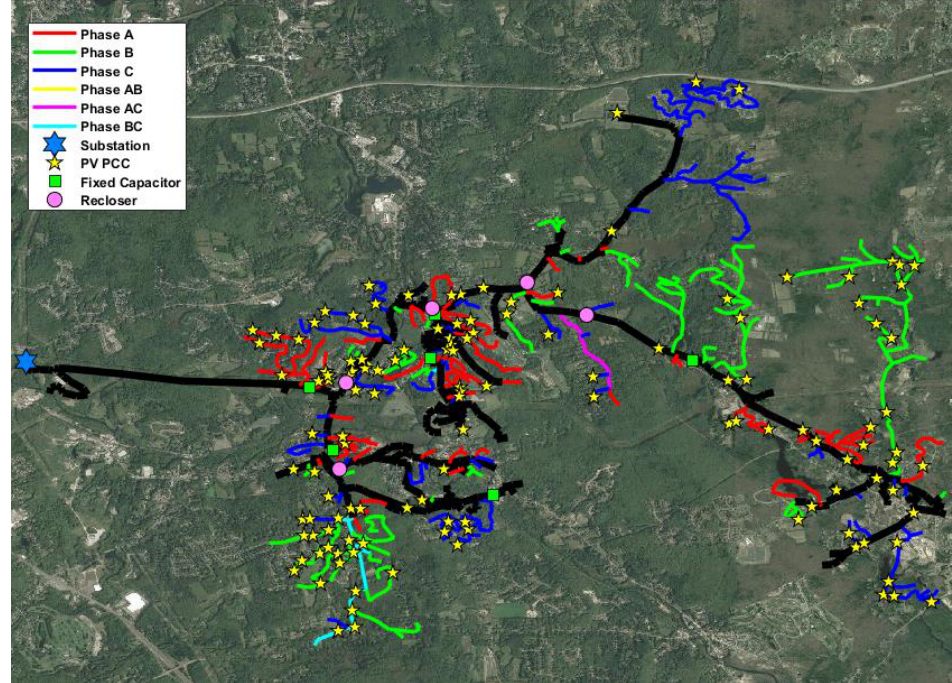
Figure 3. One-Line Diagram of NG Distribution Feeder. Google Map Layout of the OpenDSS NG Distribution Feeder without Circuit Reduction and OpenDSS Per Phase Voltage Profile Diagram.